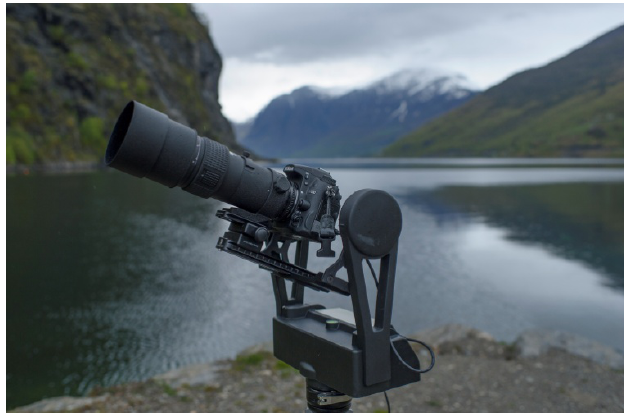
Figure 2. Giagapan Epic Pro set up with D7000 and 300 mm f4. Note that the no-parallax point (NPP) is behind the sensor